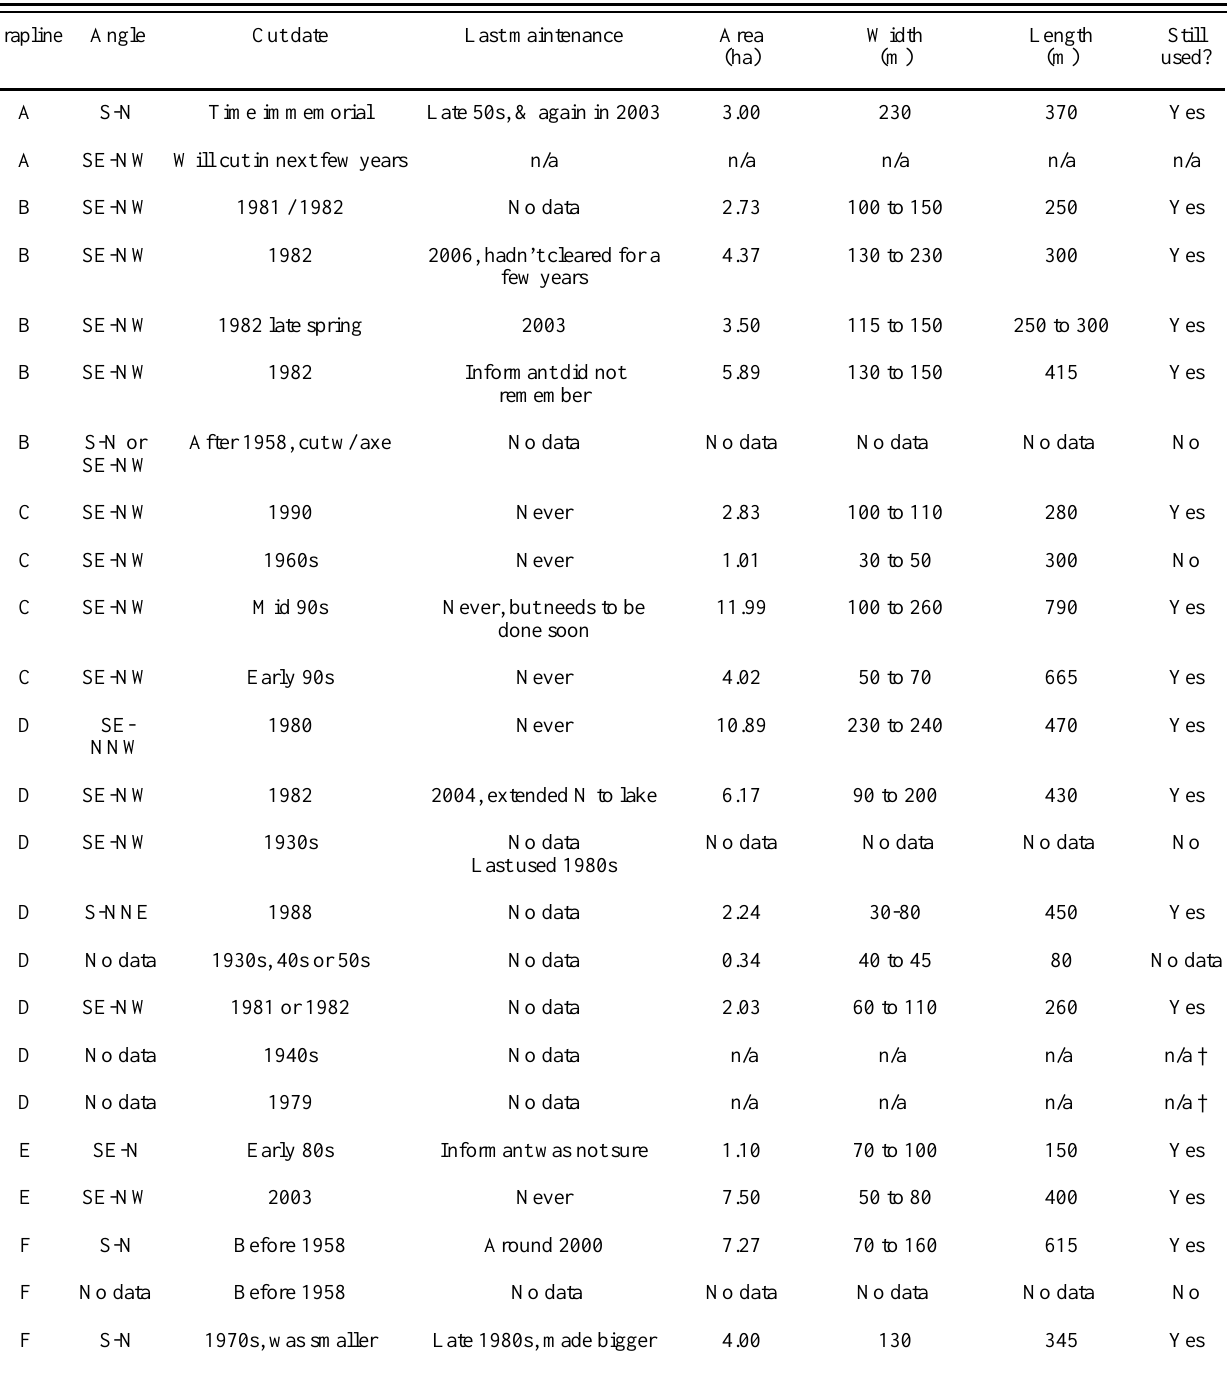
Table 2 . Selected tuuhiikan metrics for all inventoried tuuhiikaan . Many tuuhiikaan tend to be wider at one or both ends thus a minimum and maximum width was measured for each. n = 31. Hunting territory or trapline codes have no relation to spatial distribution of